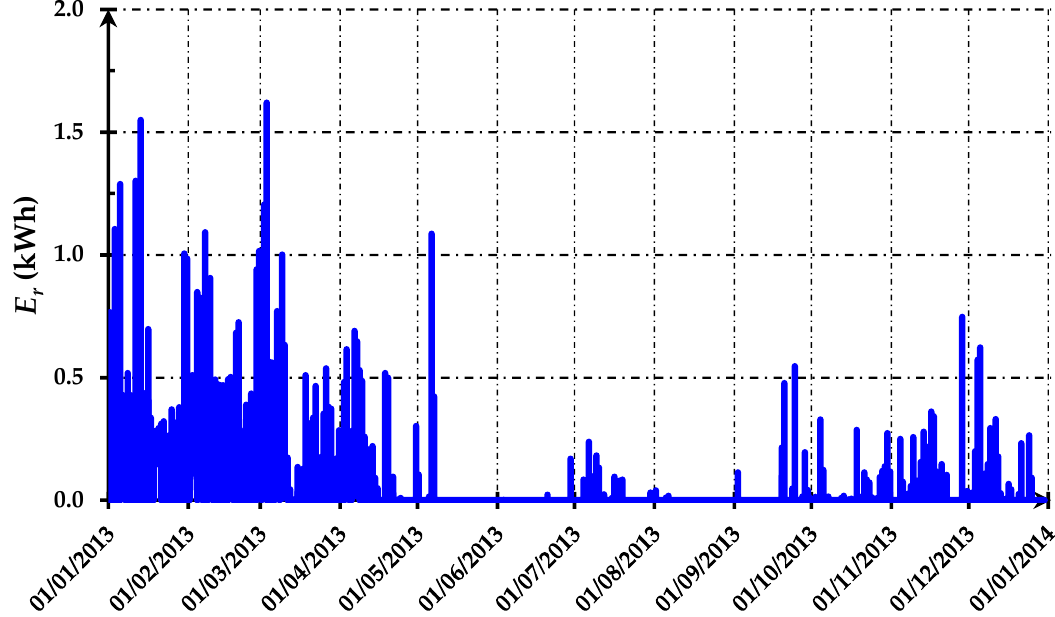
Figure 14. Active energy (Er) returned to the grid (rural power system) in 2013.